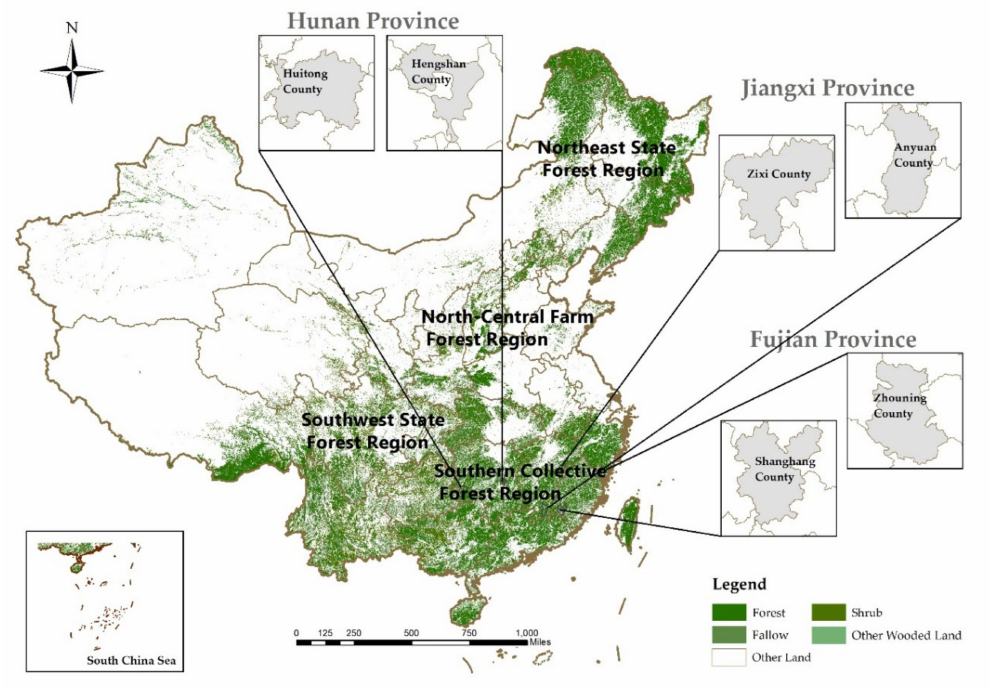
Figure 2. Forest distribution of China and data collection